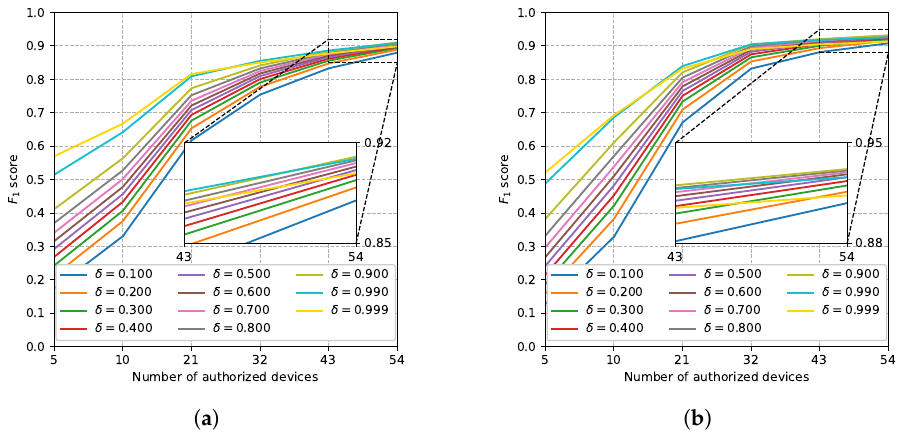
Figure 11. The F 1 scores of softmax + OvA and AAMSoftmax + OvA with different δ values. ( a ) Softmax+OvA; ( b ) AAMSoftmax+OvA.